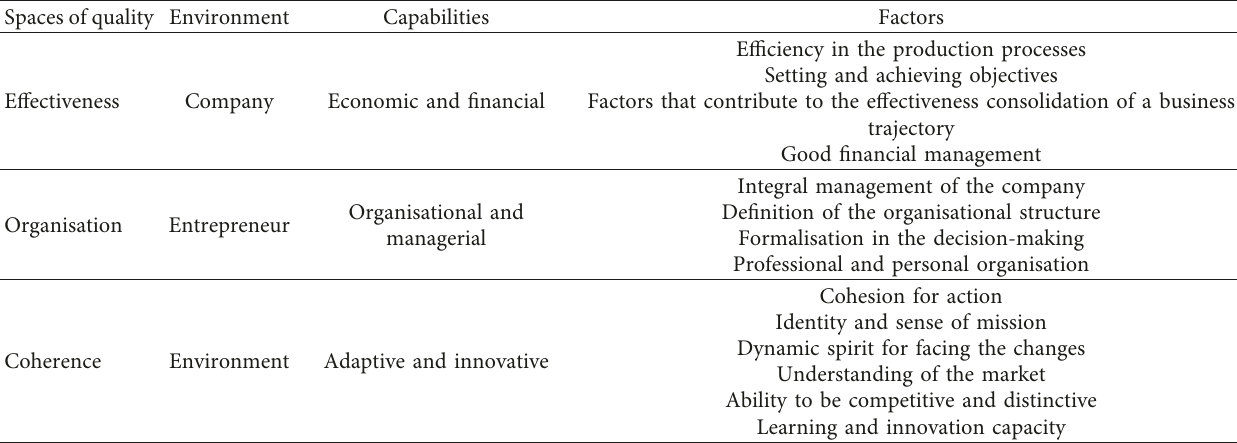
Table 2: Transfers between the delimited spaces in each of the